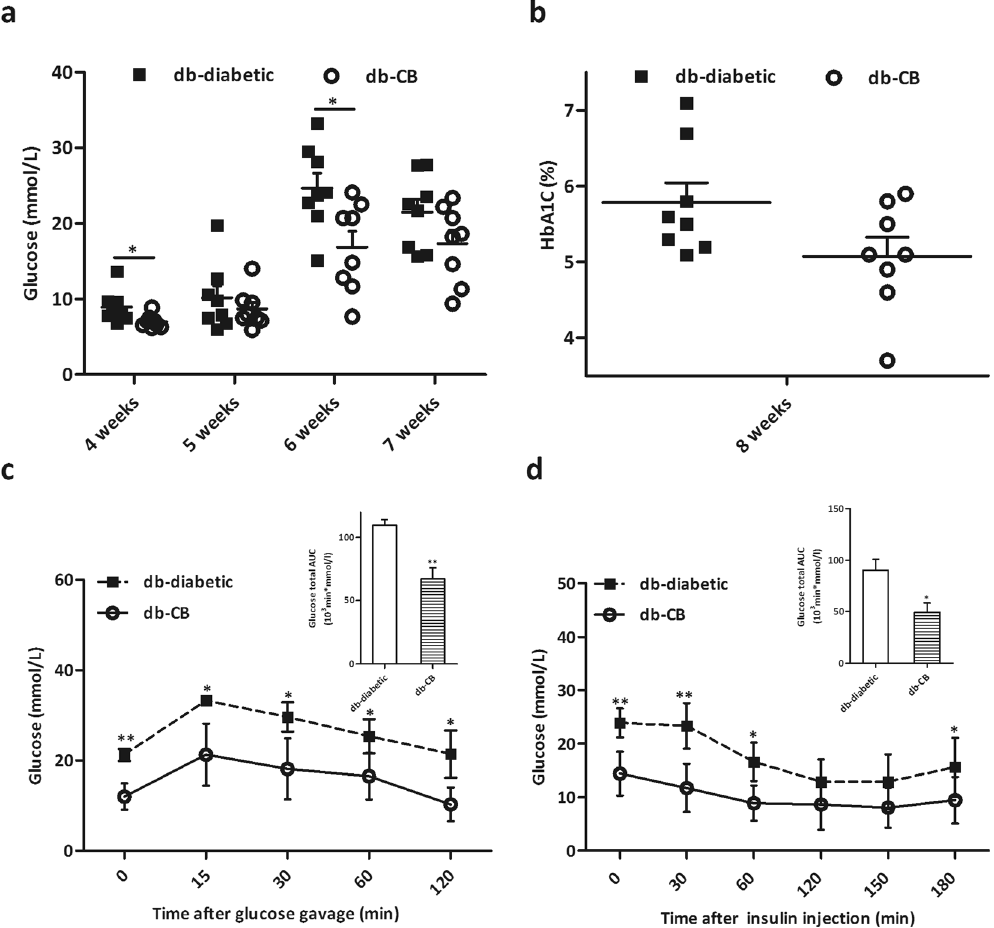
Figure 1. CB0313.1 improves hyperglycemia and insulin resistance in lep db/db mice. ( a ) Glucose was tested after 6 h fasting. ( b ) HbA1C. Glucose ( c ) and insulin ( d ) tolerance tests were performed at 8 weeks. Data are mean ± SEM (n = 4–8 mice/group). * , ** mean p < 0.05, p < 0.01 respectively vs db-diabetic control by t